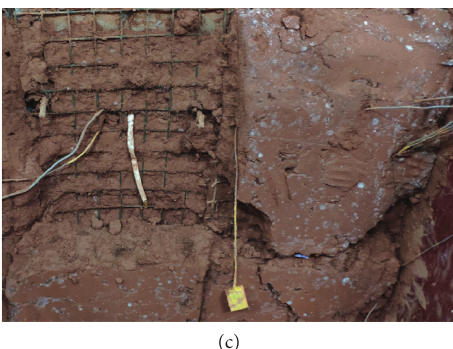
Figure 17: The failure process of SVC. (a) Stage 1: cracking stage between the substrate layer and bedrock. (b) Stage 2: internal cracking stage of the substrate layer. (c) Stage 3: vibration crushing stage of the substrate layer.